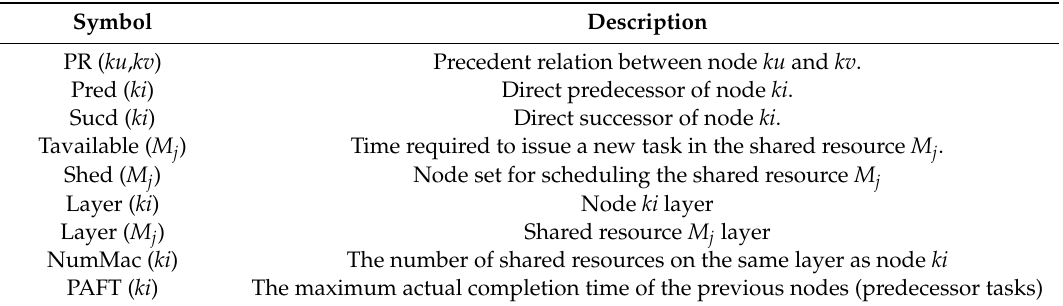
Table 1. Table of symbols.